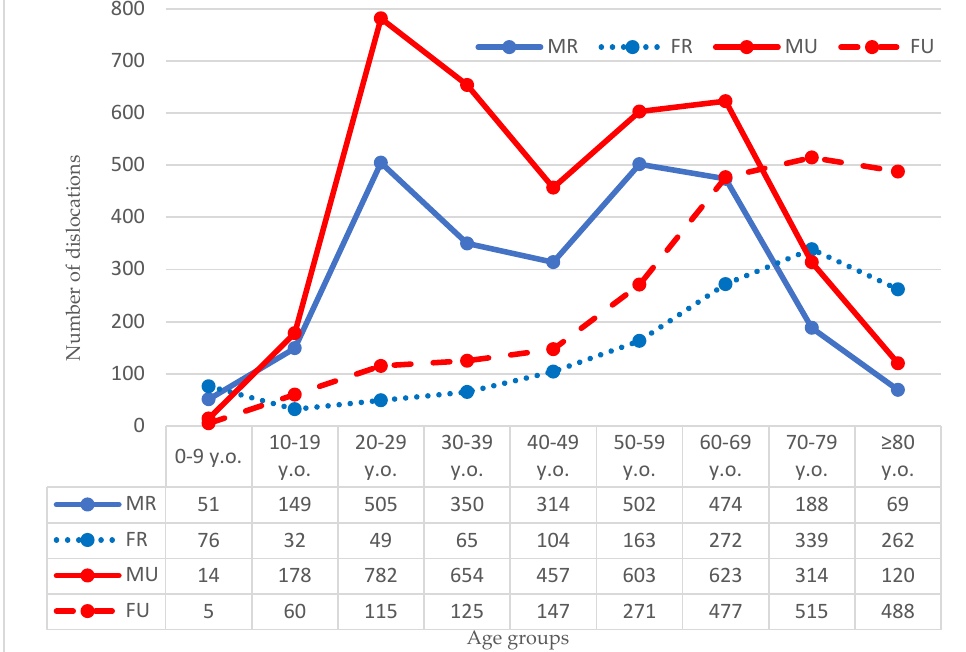
Figure 1. Number of dislocations per age group. Legend: R, rural population; U, urban population.